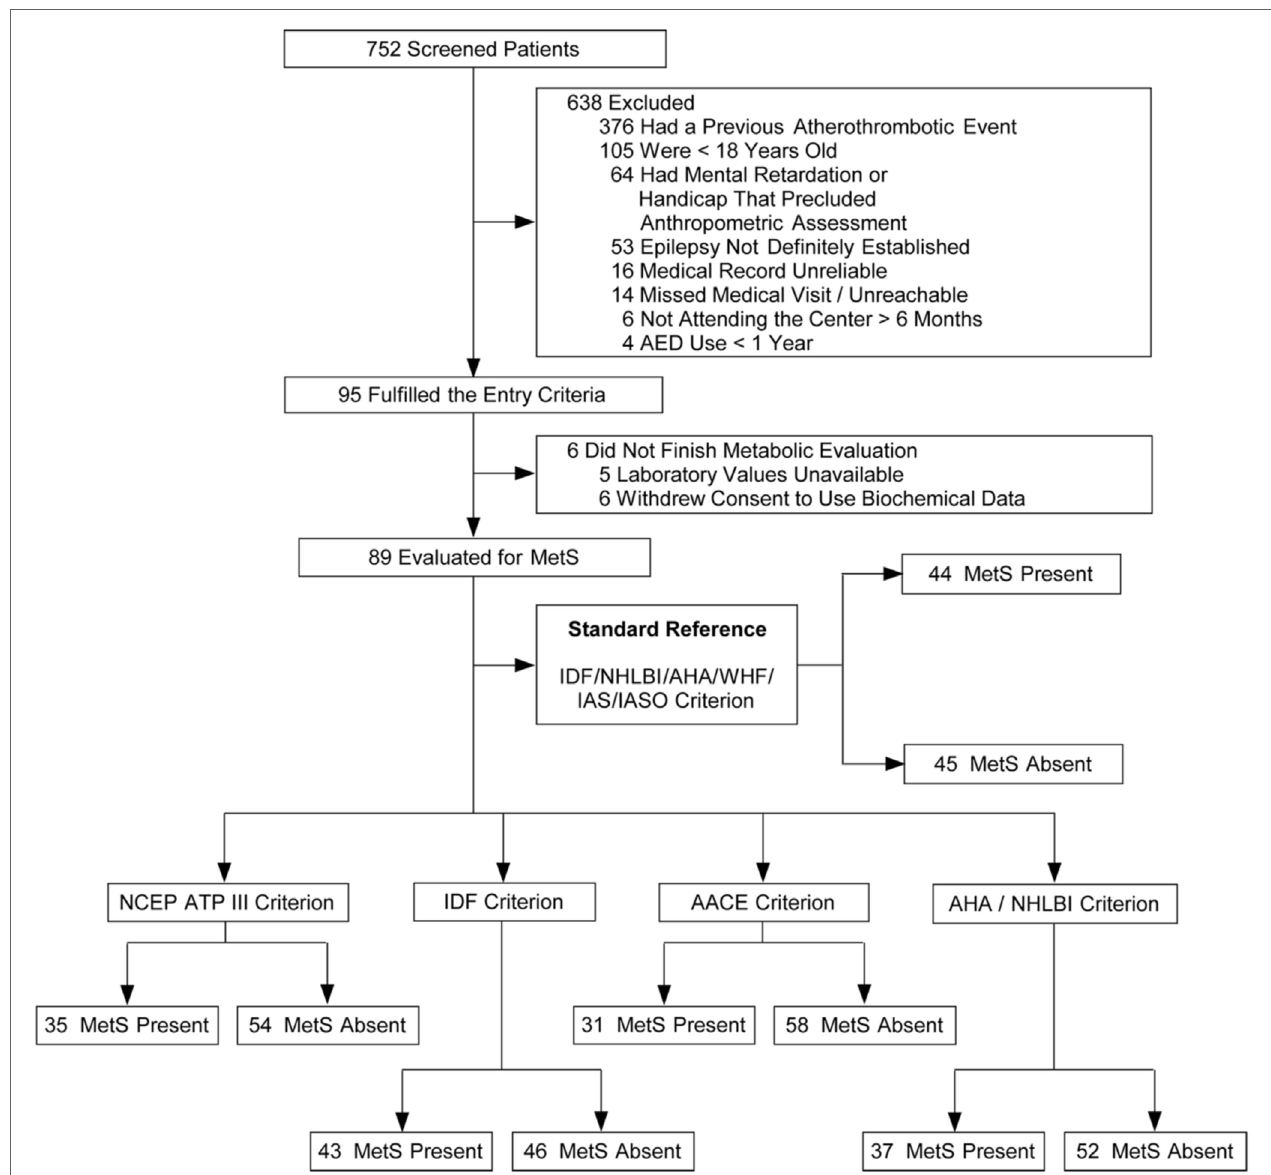
FigUre 1 | Flowcharts of the selection of patients and classification according with different metabolic syndrome (MetS)